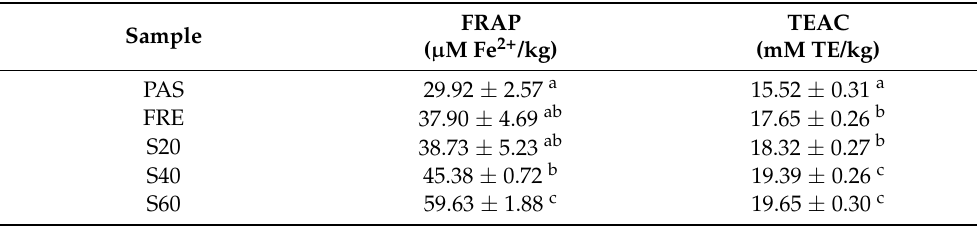
Table 4. Antioxidant